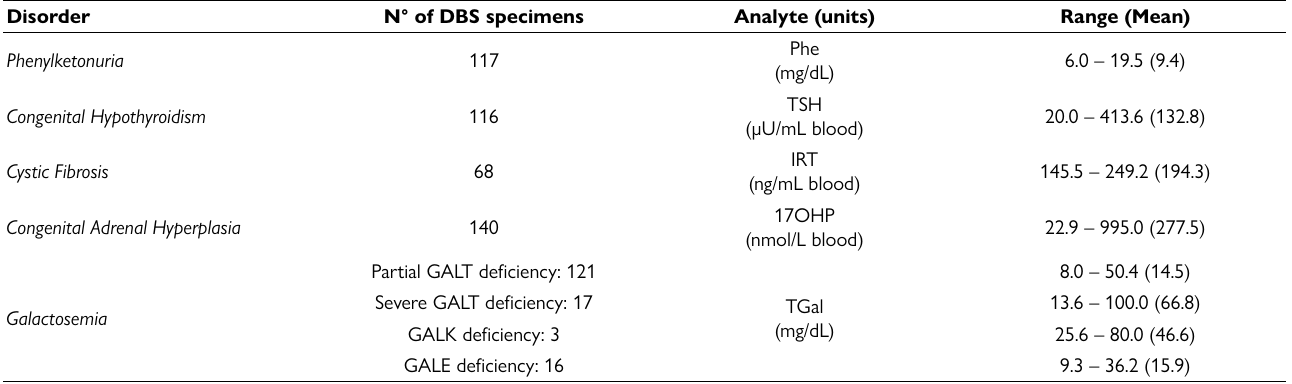
Table 2. Distribution of selected residual DBS specimens stored in uncontrolled conditions, according to the diagnosis.